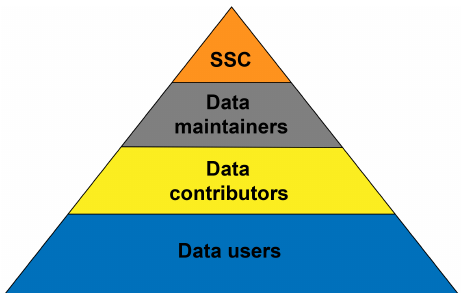
Figure 5. A simplified depiction of the ISRaD governance